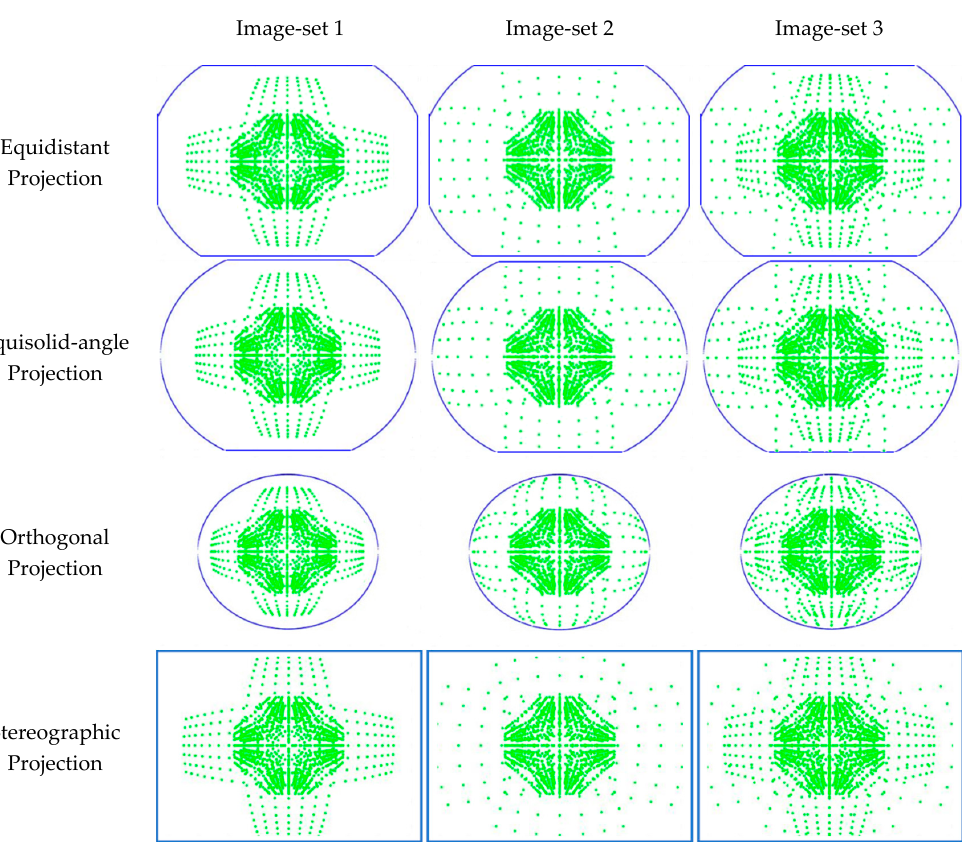
Figure 9. Distribution of image points